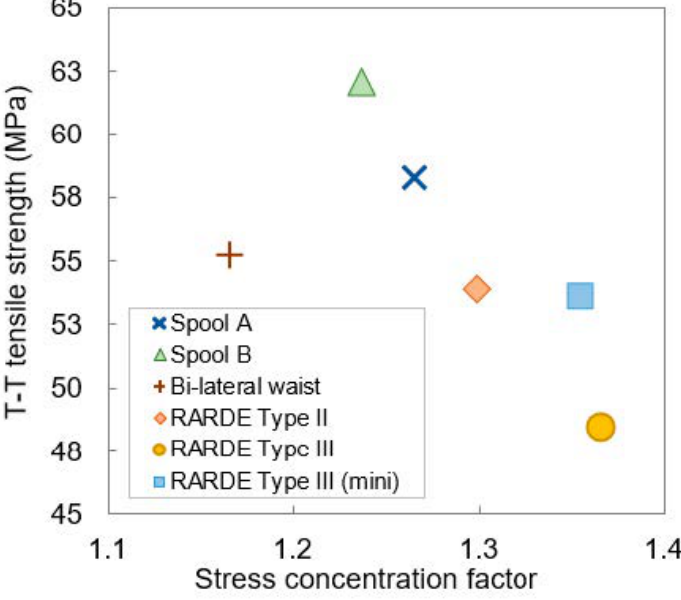
Figure 16. Failure strength plotted against stress concentration factor for all indirect